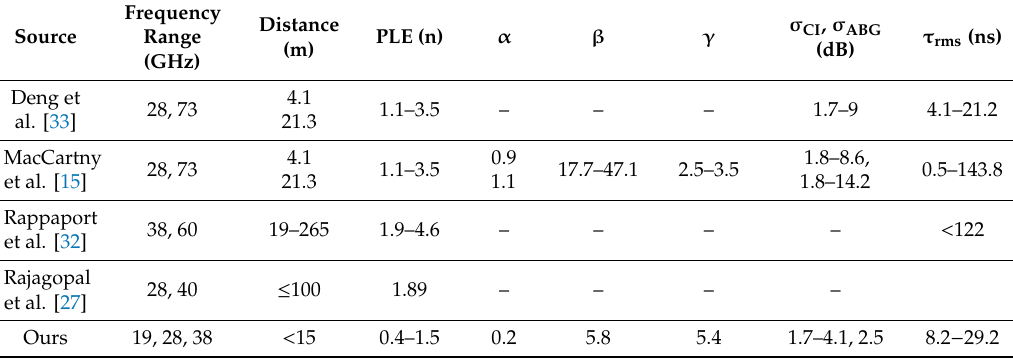
Table 4. Comparison of propagation studies for path loss models and RMS delay spread for 5G channels at mmWave